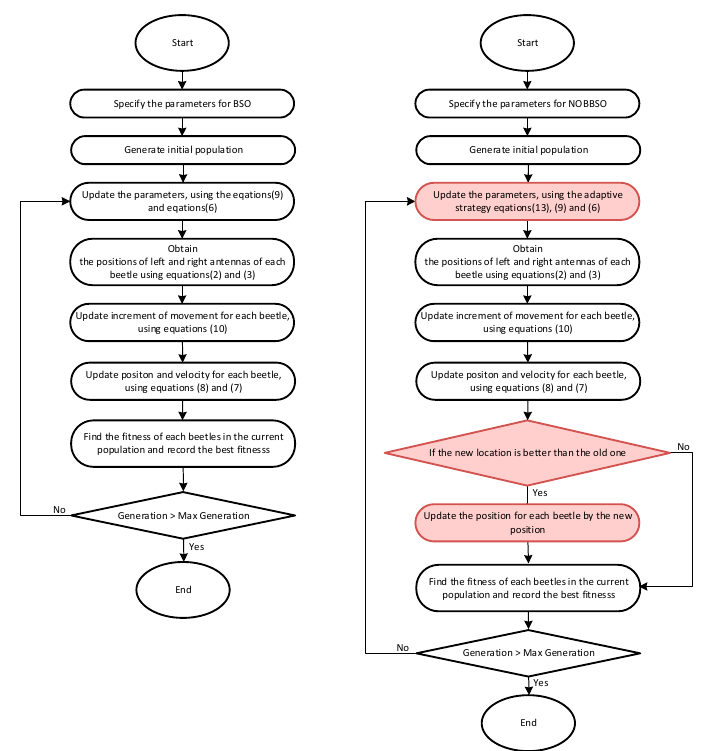
Figure 2. Flowchart of BSO and NOBBSO (the left is the BSO flow chart and the right is the NOBBSO flow chart).